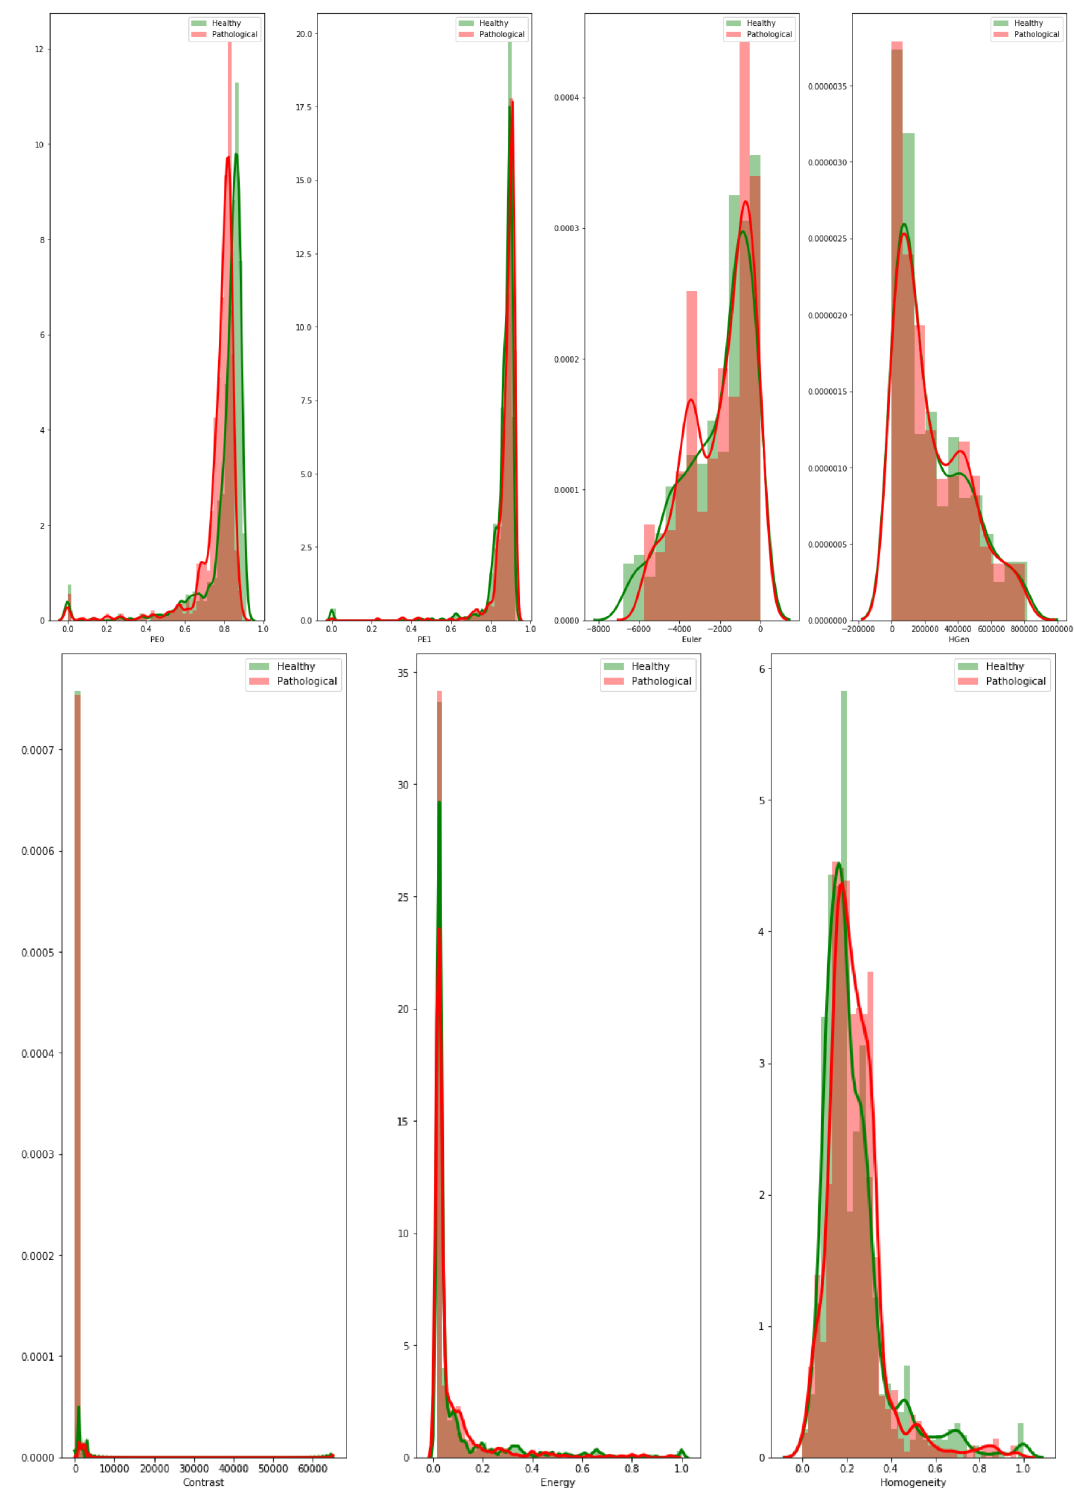
Figure 9. Density distribution of the seven selected